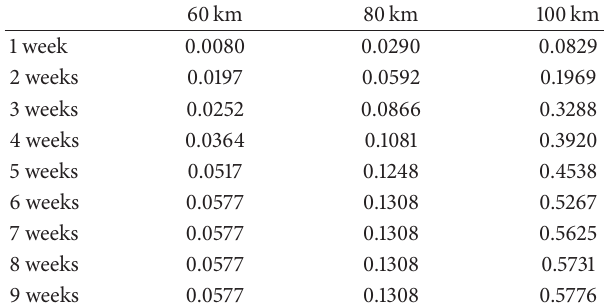
Table 2: AE as aftershock from May 9, 2011 to June 16, 2011. Cumula- tive probability 𝐶 − ( r, 𝜏 ) for radius r ranging between 60 and 100 km, and time 𝜏 varying from 1 week to 5 weeks.